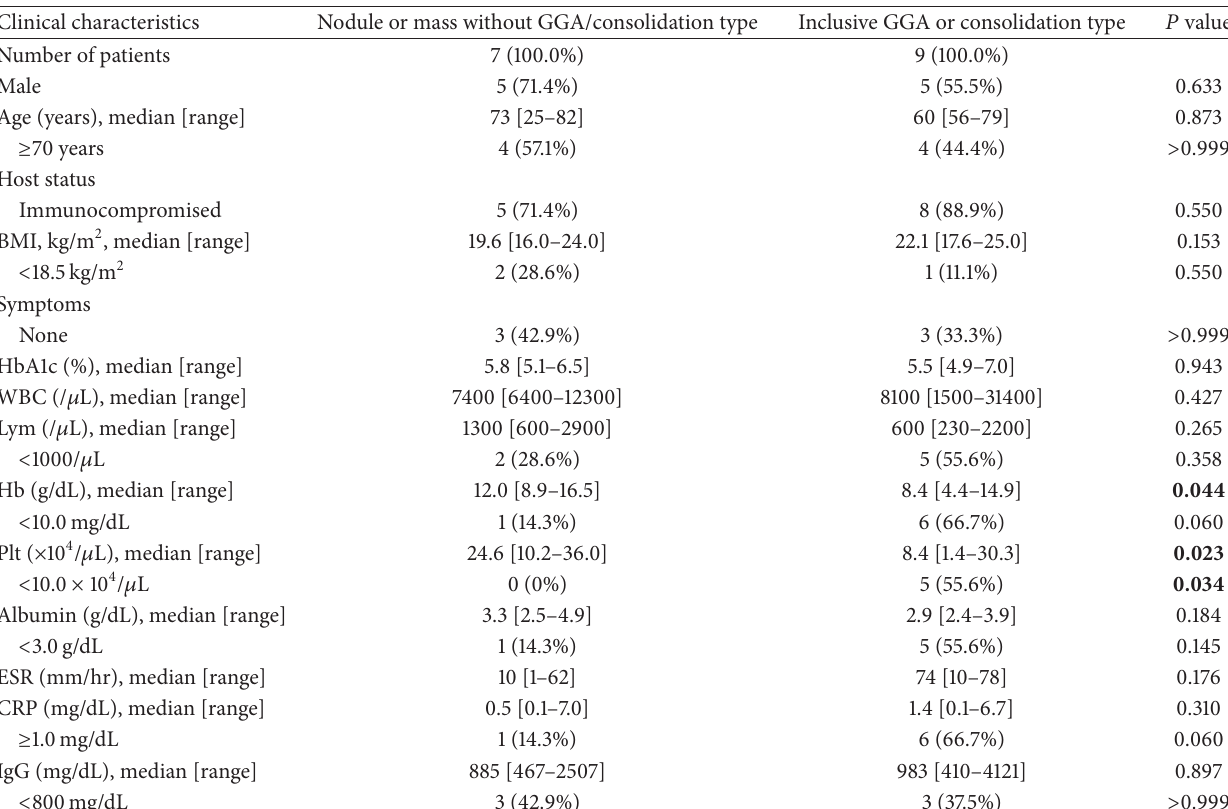
Figure 2: Representative chest CT images of pulmonary cryptococcosis in inclusive GGA or consolidation type. One patient showed multiple pale nodules with GGA in the left lung (a). Another patient showed multiple pale nodules, consolidation, and pleural effusion in the right lower lobe (b).